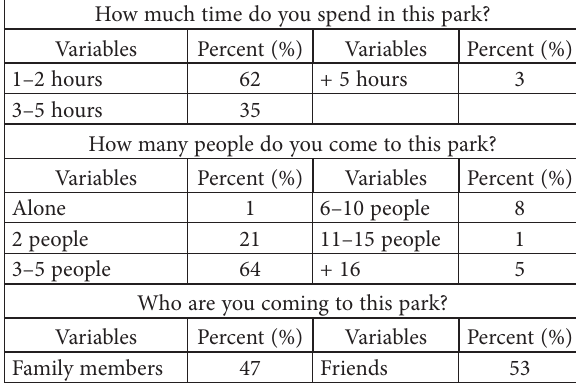
Table 6. Data on public awareness of the park